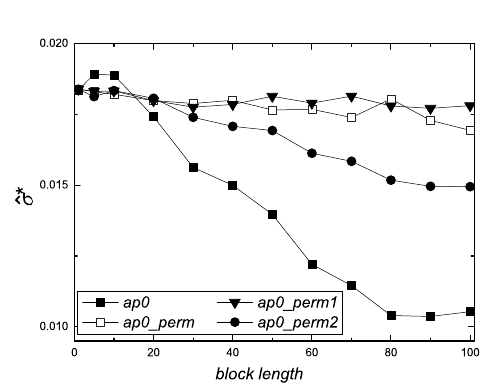
Figure 6 – Moving Block Bootstrap estimates ˆ σ ∗ of the standard error of p as a function of the block length l , for the parity ( ap0 , full squares) codon classes, computed with no frame shift for the anticodon sequence U53218 (coding region), with n = 739. Results obtained by applying the MBB to the same codon class, but with the original DNA base sequence randomly permuted are reported in empty squares ( ap0_perm ), as in Figure 4. Results with only the first base permuted ( ap0_perm1 , full triangles), with only the second base permuted ( ap0_perm2 , full circles) are also reported.